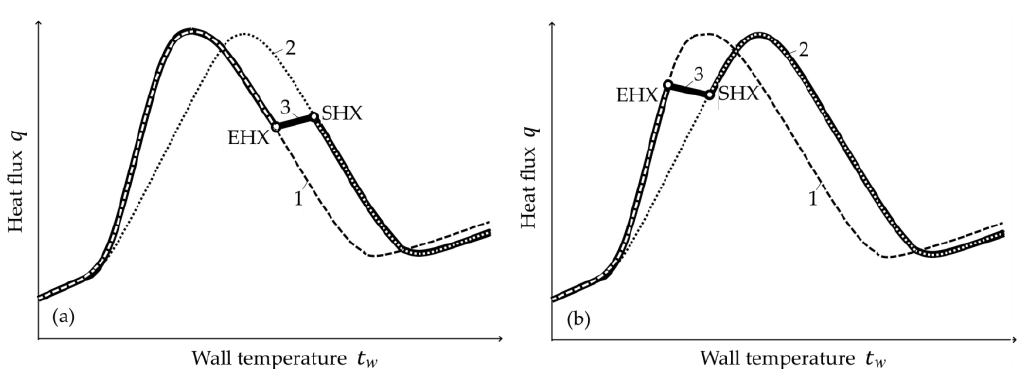
Figure 17. Schematic of boiling curve formation during water-jet cooling on the surface covered by an oxide scale. Boiling curve symbols: 1 (dashed) — on the clear metal surface without oxide scale; 2 (dotted) — on the surface with a hard scale; 3 (solid) — in cases of scale cracking. SHX and EHX — the reference points associated with oxide scale (transcript in the text). ( a ) an example of when scale cracking occurs at the transient boiling regime (in this case, oxide scale increases heat flux); ( b ) an example of when scale cracking occurs at the nucleate boiling regime (in this case, oxide scale decreases heat flux).